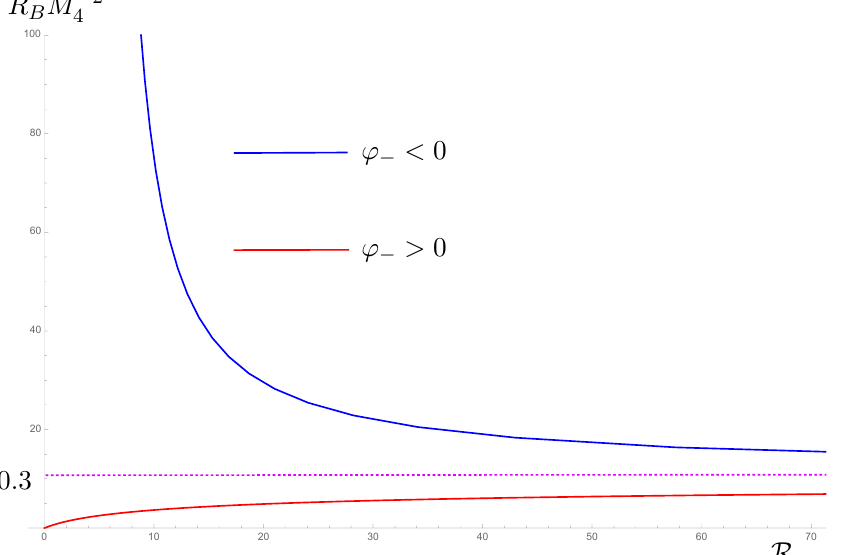
Figure 15 . Brane curvature R B M (cid:0) 2 vs. R for R > 0. Results are obtained for bulk potential (3.1), 4 brane quantities (3.6) and parameter values (3.7). For R ! 1 both the red and blue branch asymptote to the value for R B M (cid:0) 2 indicated by the dotted magenta 4